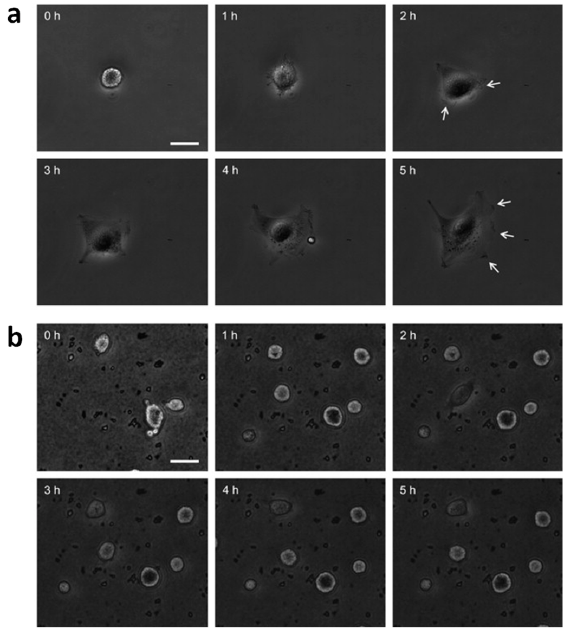
Figure 10. Dynamic cell spreading is altered by nanorods. Phase contrast imaging of human umbilical cord vein endothelial cells (HUVECs) spreading on glass and ZnO nanorods. ( a ) Cell spreading HUVECs is accompanied by lamellipodia formation (white arrows) and is complete in approximately 5 h; ( b ) Cells on nanorods do not spread, and do not develop any lamellipodia. Scale bar is 20 μ m. Modified with permission from reference [14]. Copyright (2008) Elsevier.